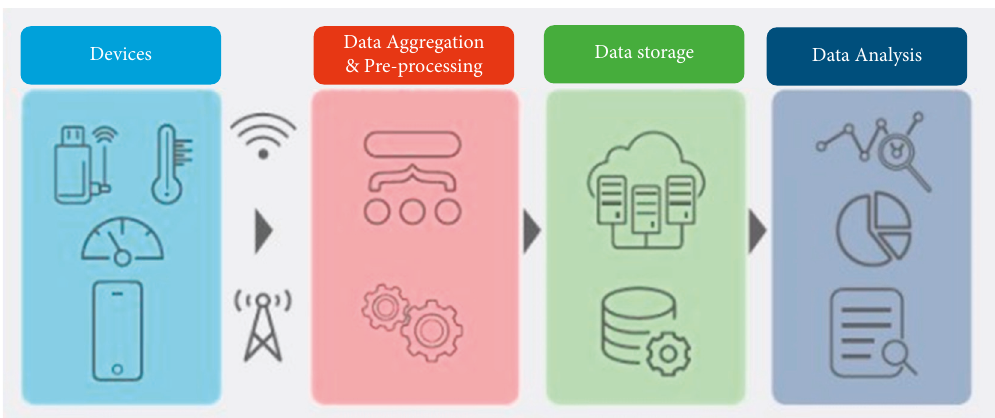
Figure 5: Usage of the IoT in healthcare